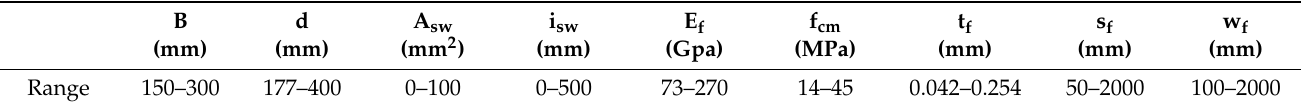
Table 4. Range of variability for the collected